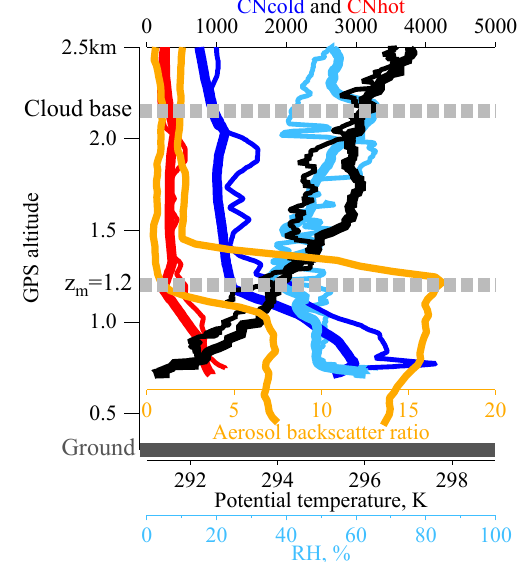
Figure 9. Relationship between BC mass and aerosol light ab- sorption from the P-3B from directly over the upgrader facilities (10 July) and from about 10km downwind (29 June). One-second data have been smoothed with a 21-point box filter, and periods on 10 July where the PSAP fluctuated wildly due to humidity transi- tions in the plumes have been eliminated. The dotted lines are not fits to the data; they are shown to illustrate that the data obtained were similar to literature values for uncoated (8m 2 g − 1 ) and coated (15m 2 g − 1 )